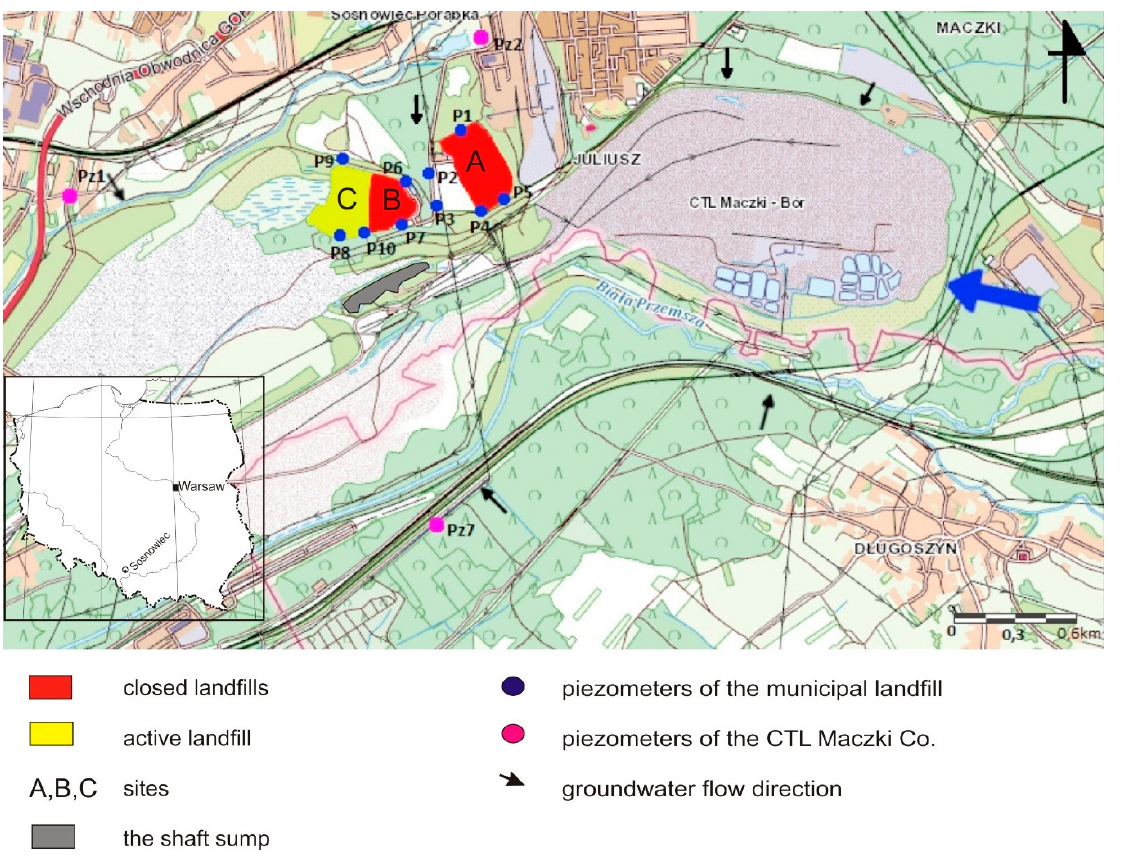
Figure 1. Study area (based on [28]).